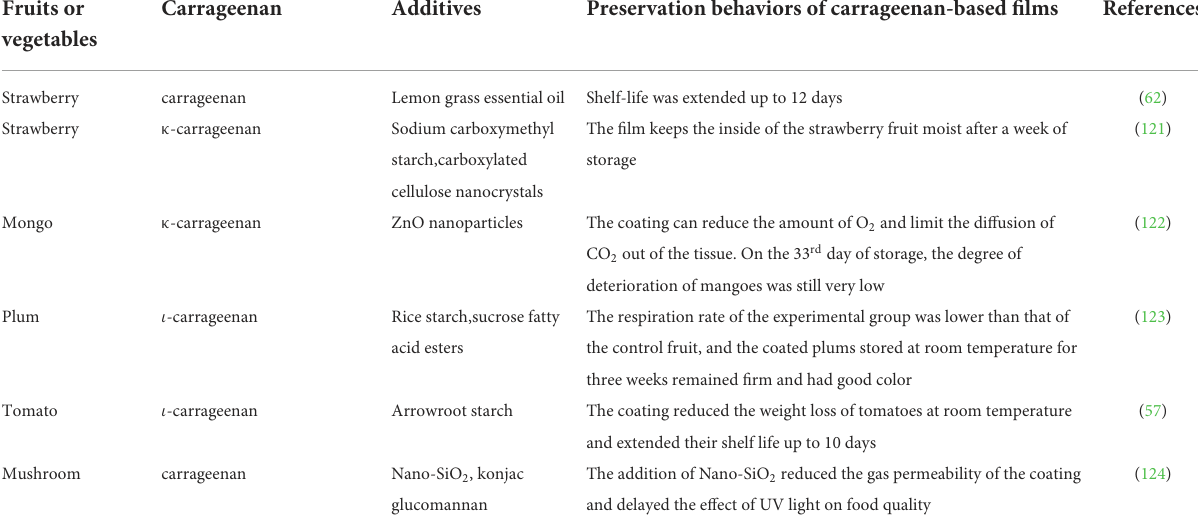
TABLE 2 Application of carrageenan-based